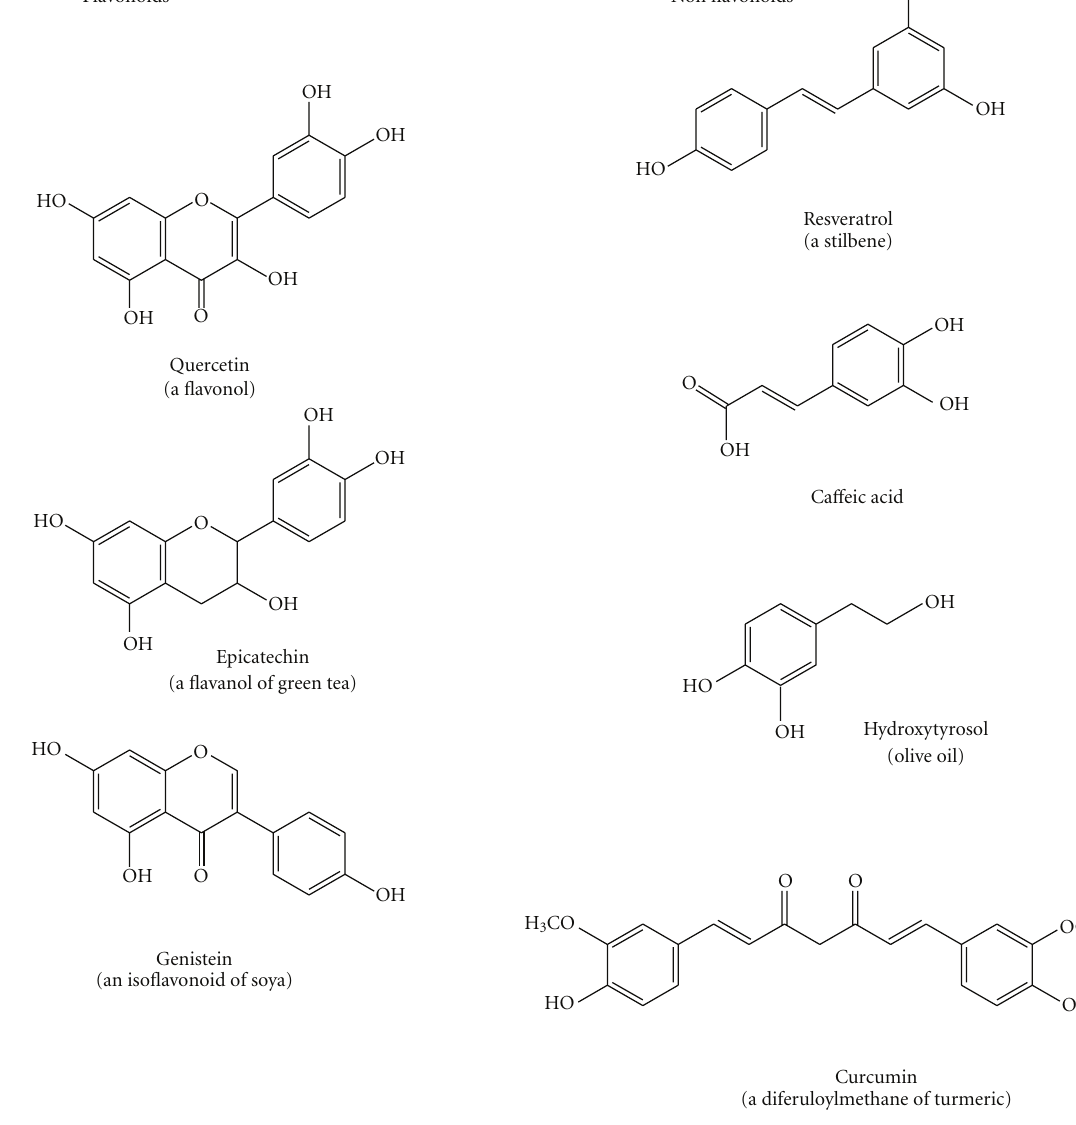
Figure 7: Structure of the most important